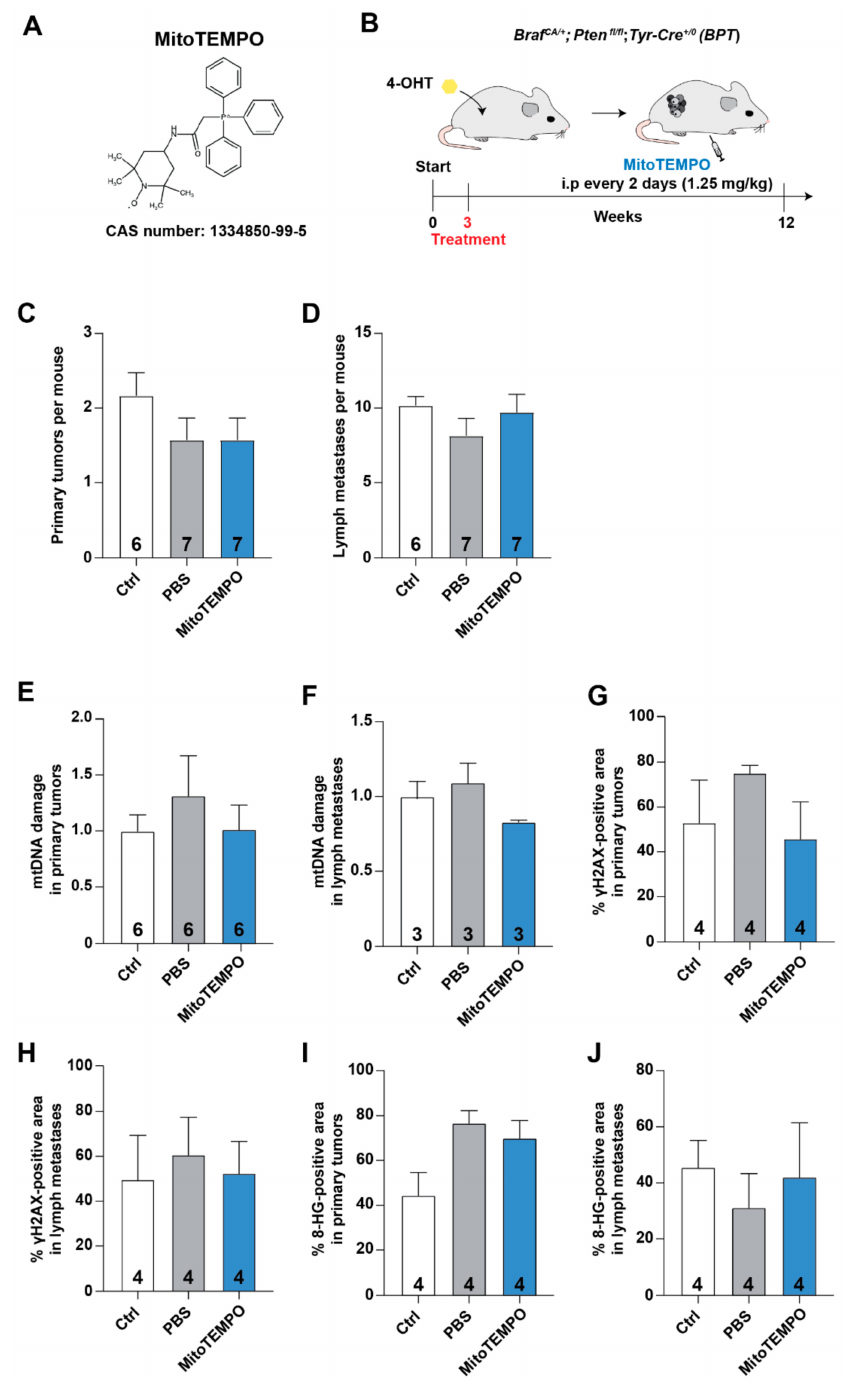
Figure 2. The mitochondria-targeted antioxidant MitoTEMPO does not influence malignant melanoma progression in mice. ( A ) Structure of MitoTEMPO. ( B ) Schematic showing how two-day-old BPT mice were painted with 4-hydroxytamoxifen on the flank skin to activate BRAF 600E expression and inactivate PTEN expression in melanocytes (start). MitoTEMPO (1.25 mg/kg) or vehicle (PBS) were injected i.p.—starting at weaning (3 weeks)—every other day for a total of 30 injections; a separate group of mice were left untreated (Ctrl). ( C ) Number of primary tumors in Ctrl BPT mice and BPT mice injected with PBS or MitoTEMPO. ( D ) Number of lymph node metastases in Ctrl BPT mice and BPT mice injected with PBS or MitoTEMPO. ( E , F ) Quantification of mitochondrial DNA (mtDNA) damage in primary tumors ( E ) and lymph node metastases ( F ); data are normalized to Ctrl. ( G , H ) Percent γ H2AX-positive area in primary tumors ( G ) and lymph node metastases ( H ). ( I , J ) Percent 8-HG-positive area in primary tumors ( I ) and lymph node metastases ( J ). Numbers in bars = n